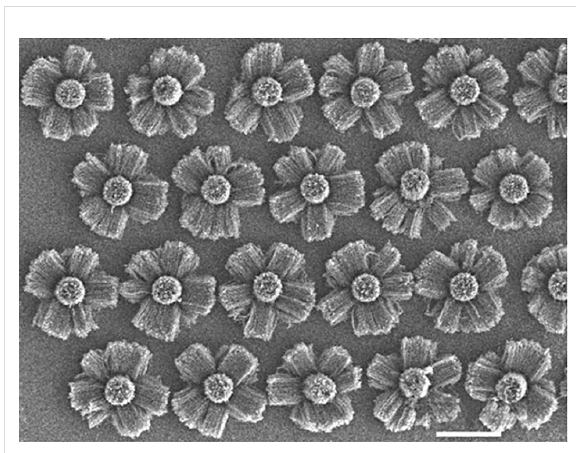
Figure 6: SEM image of beautiful repeating patterns of multiply oriented, organized nanotube structures on deep (about 5 μ m) silica features (circular cross section), machined on silicon substrates. Growth in the vertical direction occurs from the top silica surface (seen as arrays emanating from the center of each pattern); growth on the sides occurs as horizontal arrays (sideways growth seen on each pattern) (scale bar, 50 µm). Adapted with permission from [69]. Copy- right 2002 Nature Publishing Group.